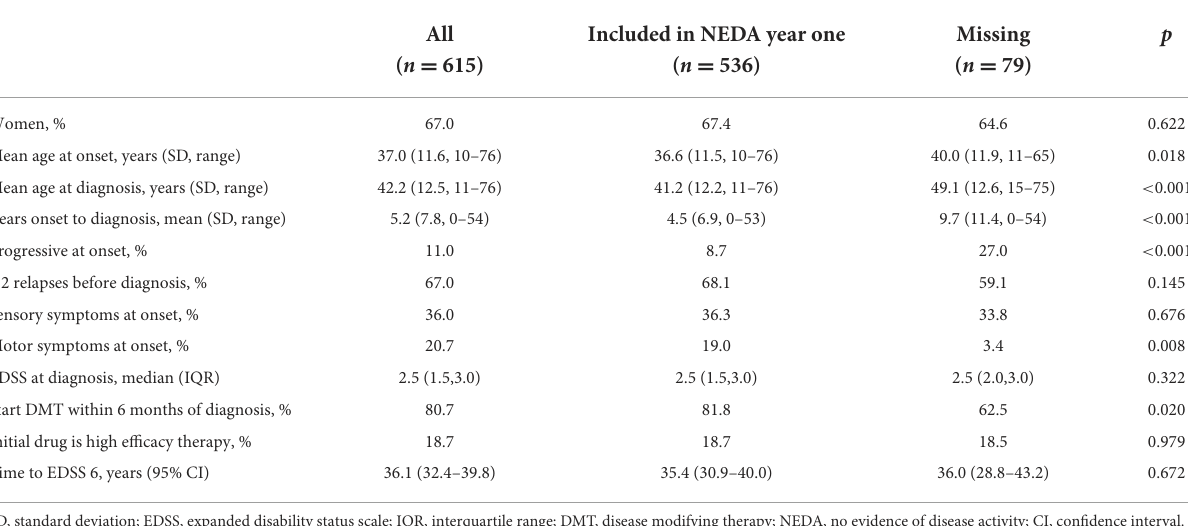
TABLE 1 Demographic information on the population as a whole and those included and missing.